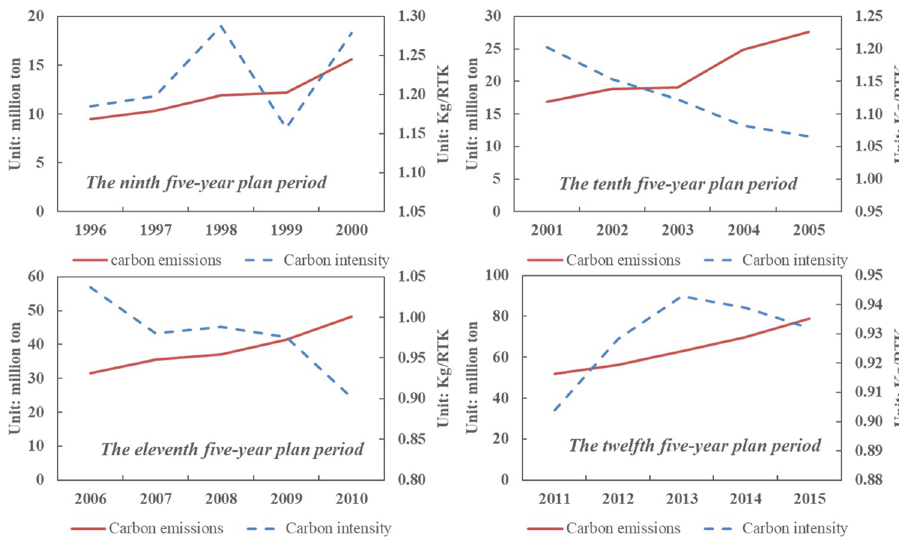
Fig 1. CO 2 emissions and carbon emission intensity of China’s civil aviation,